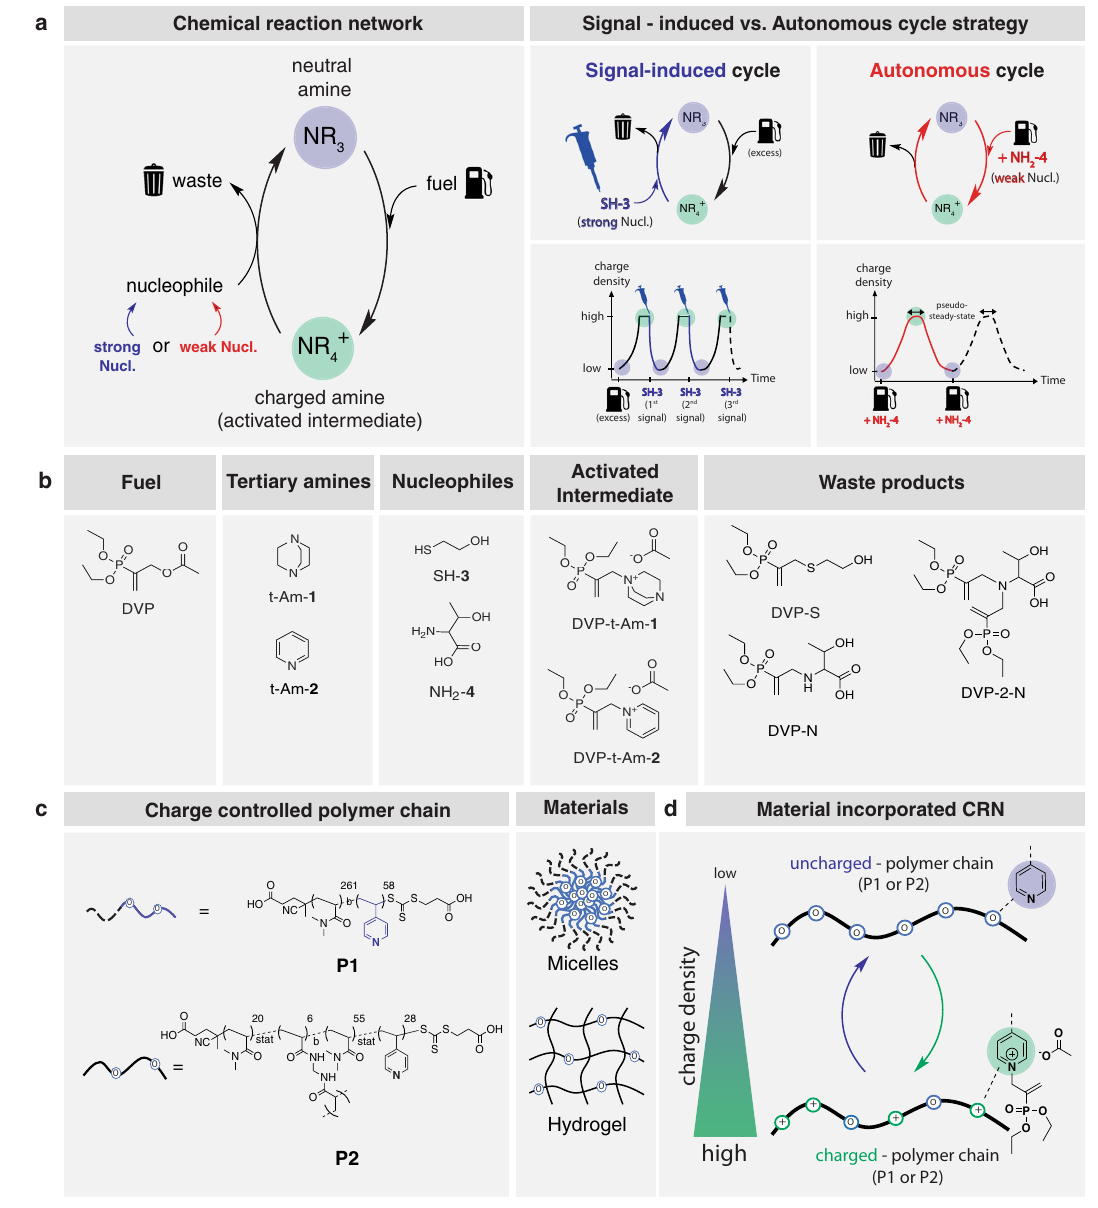
Fig. 1 | Schematics of the chemical reaction network (CRN), its conditions and components.a Generic CRN and CRNstrategy used to achieve stimuli-responsive or autonomous material changes. b Chemical structure of fuel, nucleophiles and tertiary amines (used in the small molecule model CRN), as well as their activated intermediates and waste products. c RAFTsynthesised polyamine copolymers(P1, P2)usedforthepreparationofpolymericmaterials:(1)micellardispersionsand(2) bulk polymer hydrogels. d Temporally programmed charge (de)formation on